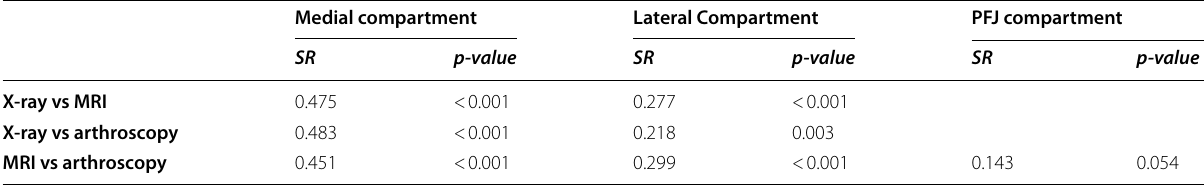
Table 5 Spearman’s Rho results with p -values Medial